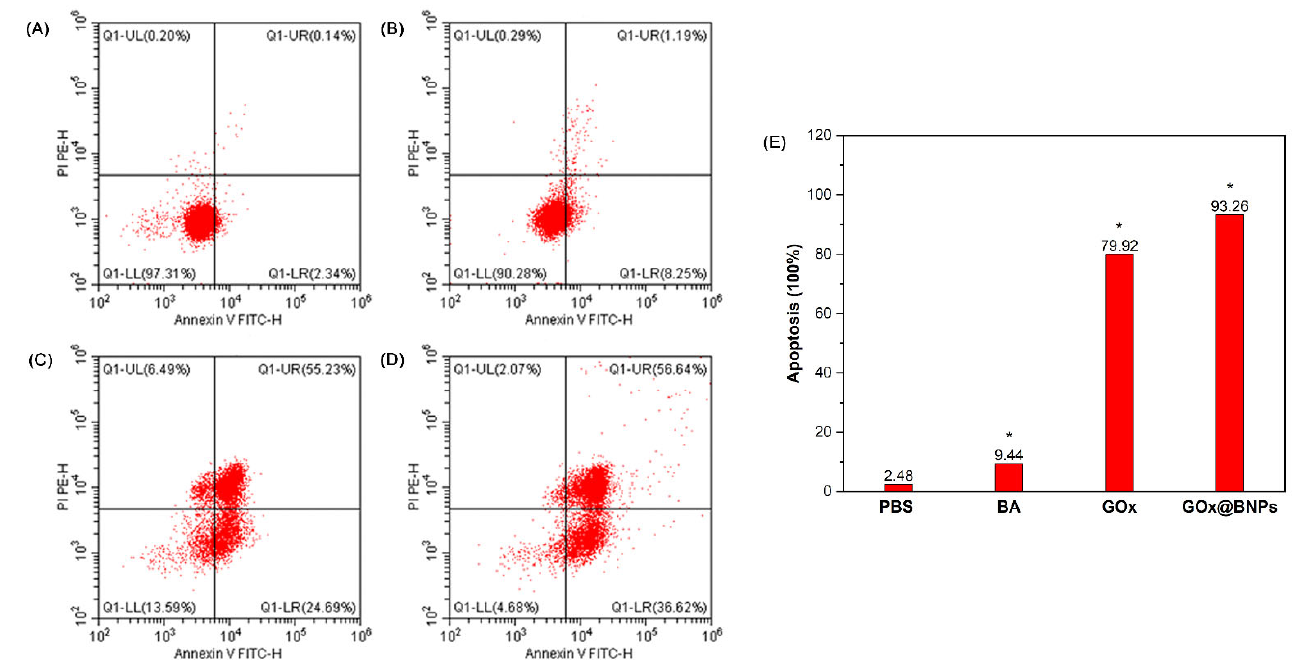
Figure 9. Representative graphs and statistical analysis of Annexin V-FITC/PI staining. Flow cytometric analysis of Annexin V-FITC/PI stained A549 cells treated with ( A ) PBS; ( B ) BA; ( C ) GOx; and ( D ) GOx@BNPs. ( E ) Statistical analysis the apoptosis rates of A549 cells at 37 ◦ C for 12 h. Inserted numbers in the profiles indicate the percentage of the cells present in this area. Date are expressed as the mean ± S.D., n = 3 (* p < 0.05).